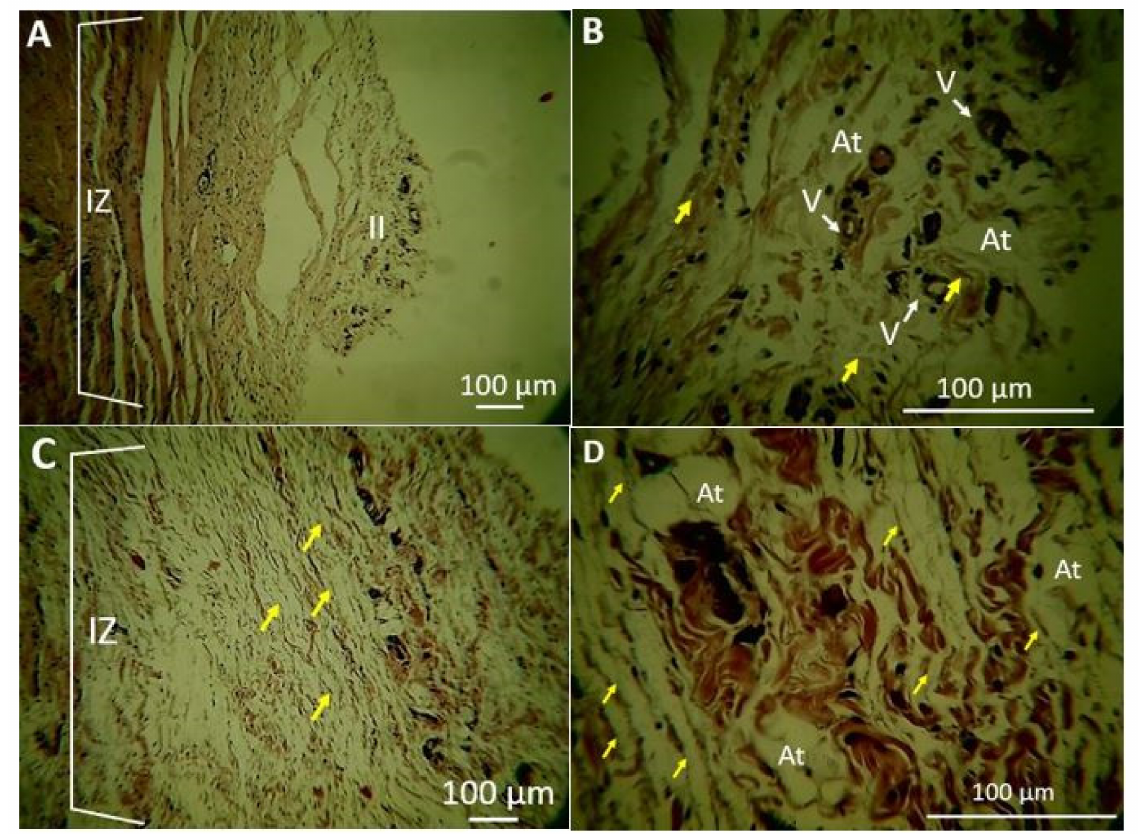
Figure 10. Nanocomposite F4 implanted in the subdermal zone of the Wistar rat at 30 and 90 days. ( A , B ) correspond to 30 days, ( C , D ) correspond to 90 days. ( A ) at 10 × . ( B ) at 40 × . ( C ) at 10 × and ( D ) at 40 × . IZ. Implantation area. II: inflammatory infiltrate V: blood vessel. At: adipose tissue. Yellow arrows: implanted material. Hematoxylin and Eosin Technique